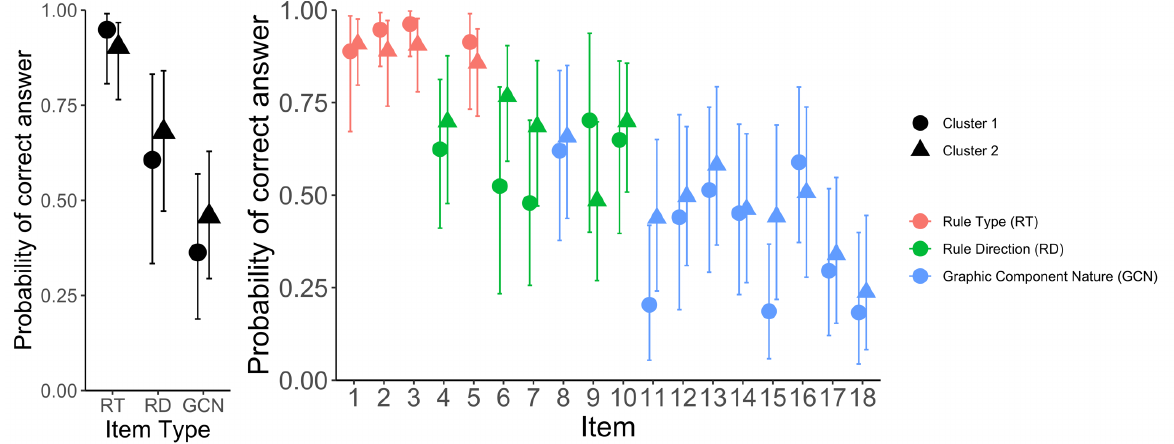
Figure 12. Left panel shows the interaction between the three item types and the cluster with respect to the probability of correct answer. Right panel shows the probability of a correct answer for each cluster and each item separately. Error bars represent 95% credible